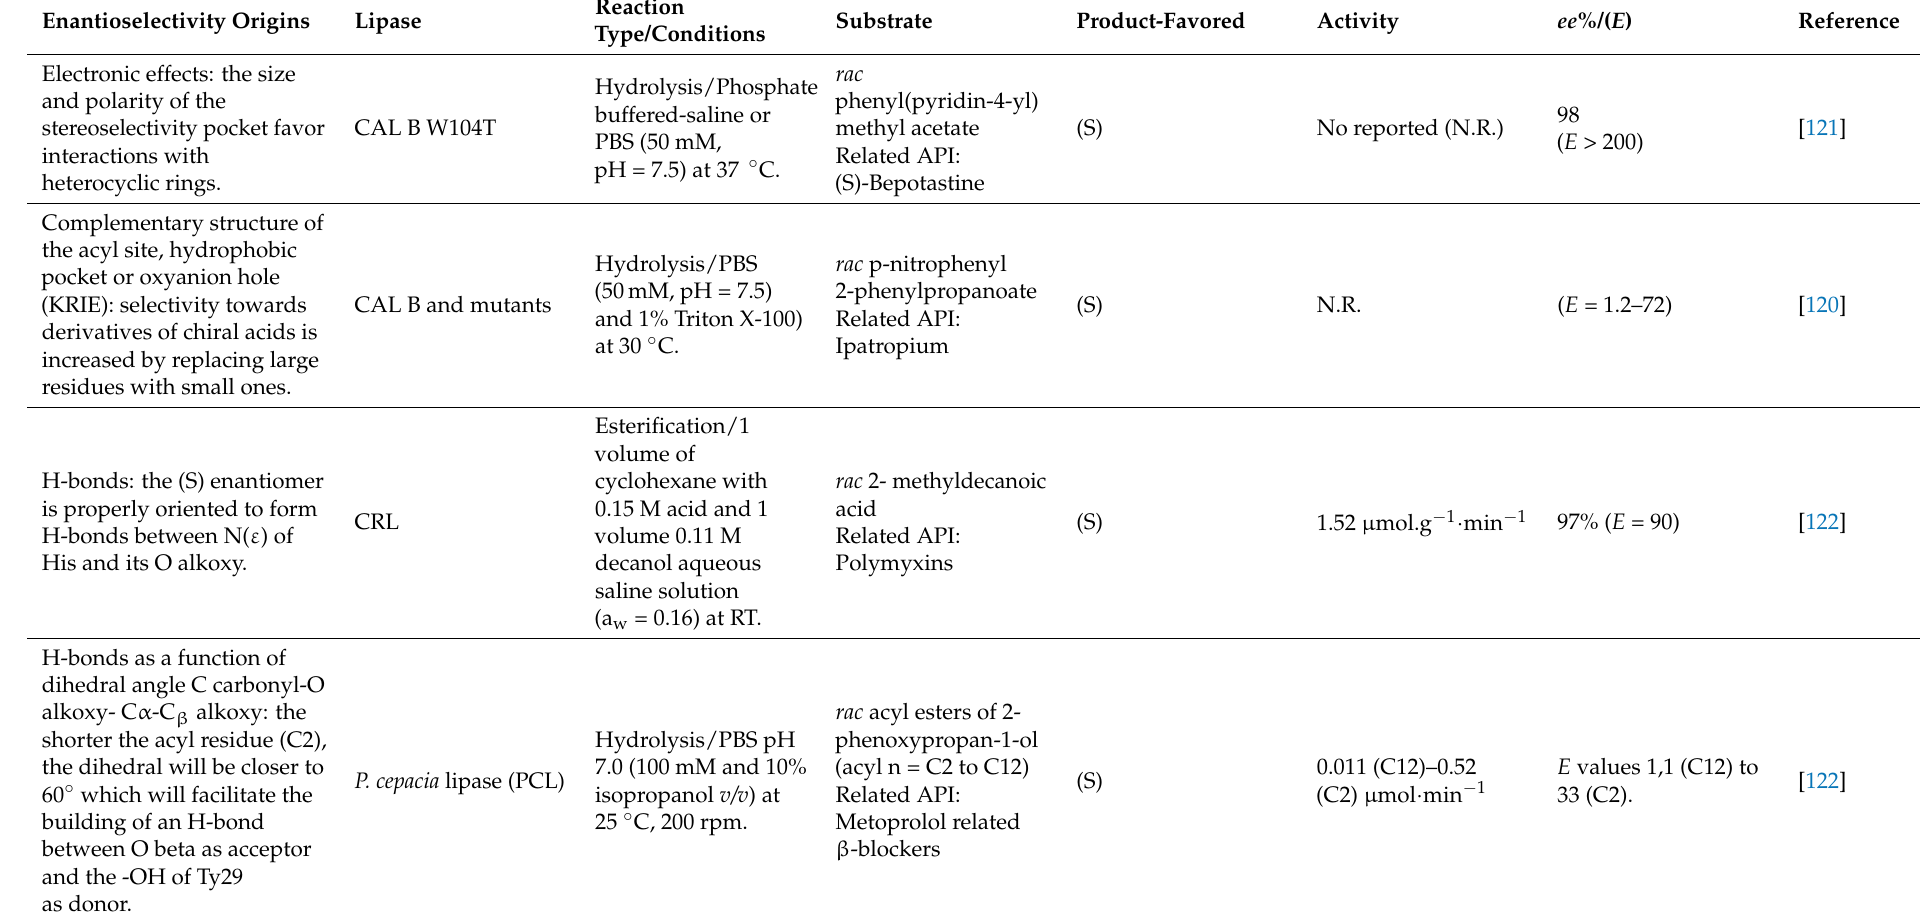
Table 1. Some cases of enantioselectivity: explanation, type of reaction and details of the reaction